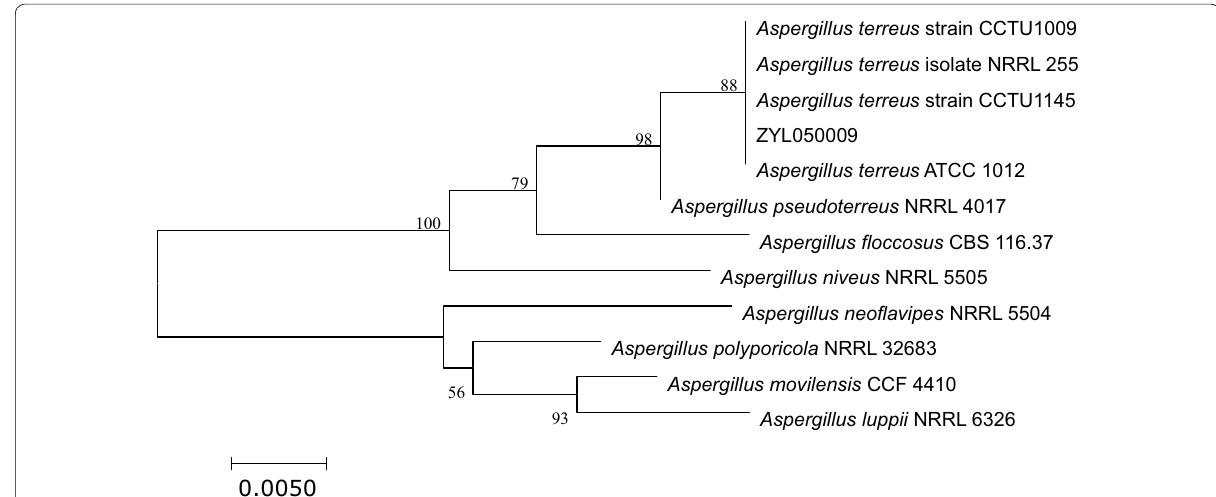
Fig. 2 Phylogenetic tree based on the ITS sequences was generated using the neighbor-joining method and the MEGA7.0 software. All sequences data were retrieved from the GenBank database. Bootstrap values, expressed as percentages of 1000 replications, are given at branching